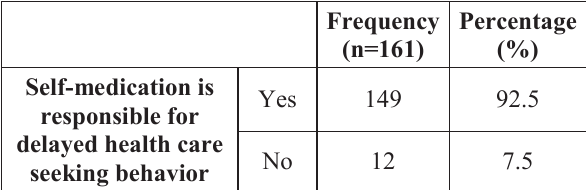
Table-3: Self-medication responsible for delayed health care seeking.